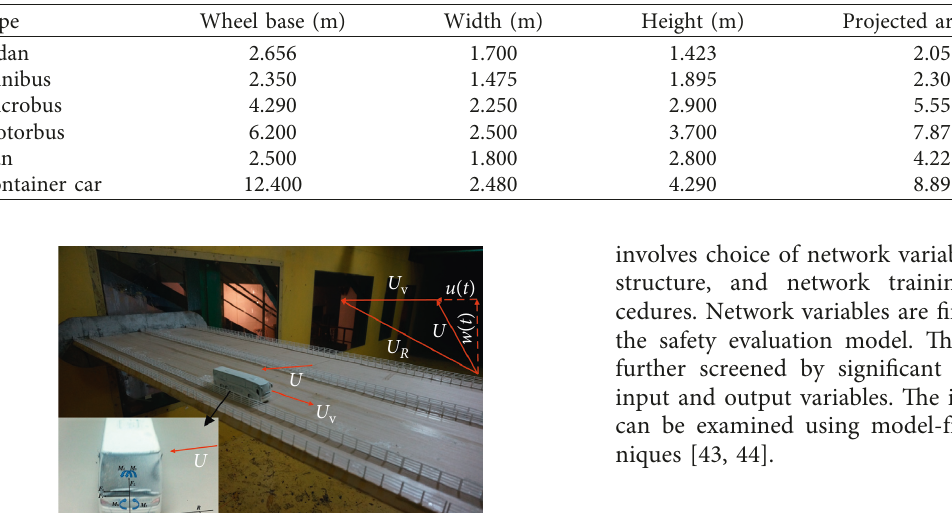
Table 2: Basic parameters of vehicles.